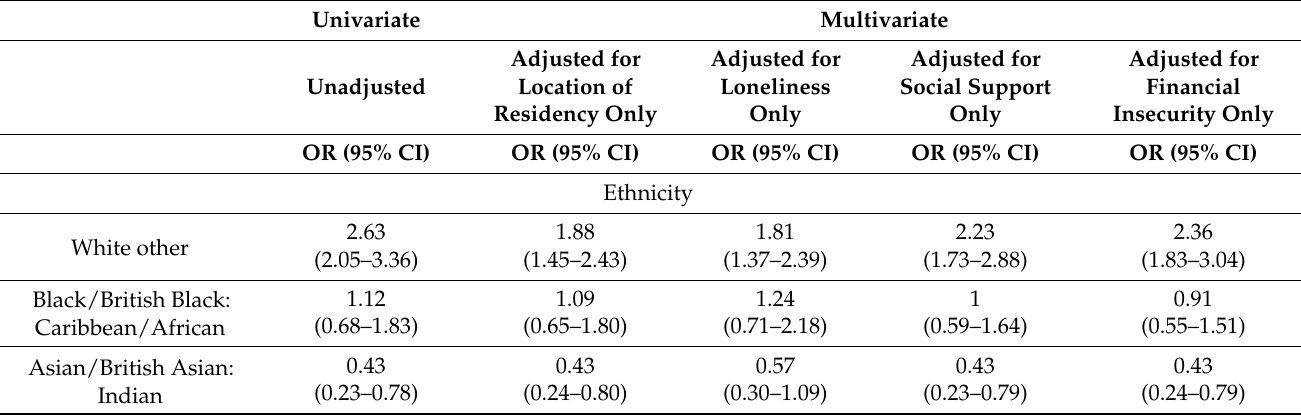
Table 3. Associations between ethnicity and clinically important depressive symptoms ( n =